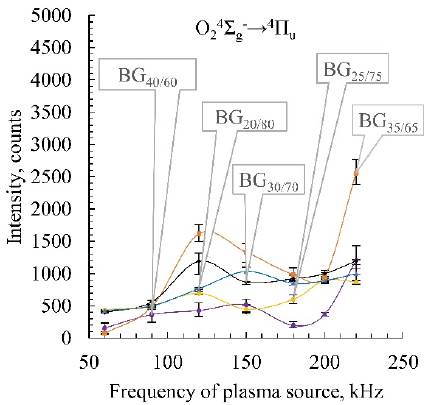
Figure 7. Graphs of intensity deviation according to frequency: ( A ) for CH+ radical; ( B ) for OH radical.